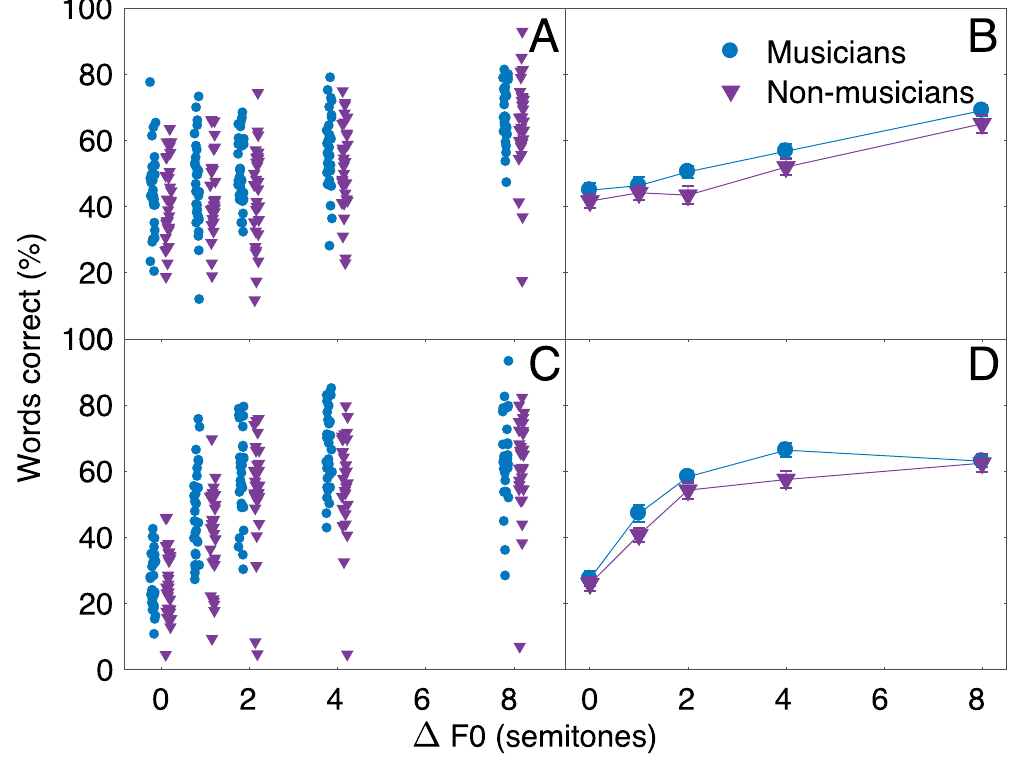
Figure 3. Proportion of words correctly identified for natural speech ( A and B ) and monotone speech ( C and D ) as a function of difference in overall mean fundamental frequency ( Δ F0) of target and maskers. ( A and C ) Speech scores for each participant. ( B and D ) Means across participants in each group. Error bars indicate ± 1 standard error of the